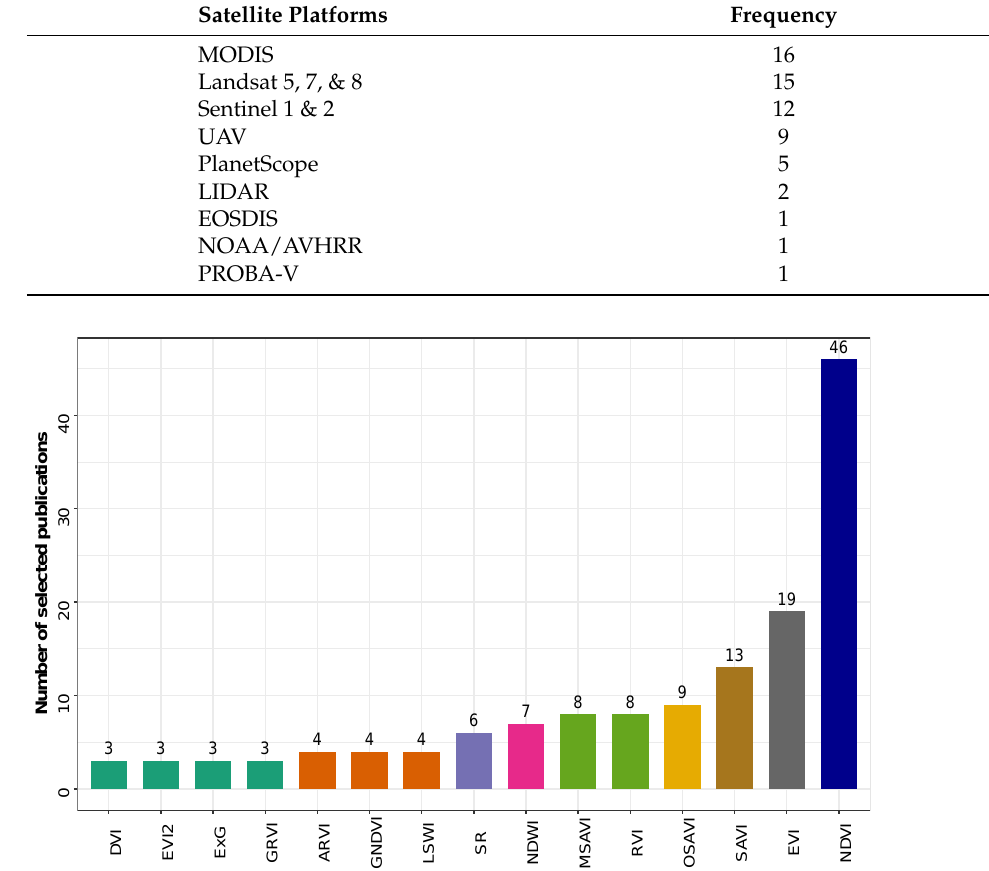
Figure 2. Vegetation indices versus the number of selected publications collected from database sources. Frequency of use of vegetation indices is sorted from lowest to highest. NDVI—normalized difference vegetation index, EVI—enhanced vegetation index, SAVI—soil-adjusted vegetation index, OSAVI—optimized soil-adjusted vegetation index, RVI—relative vigor index, MSAVI—modified soil-adjusted vegetation index, NDWI—normalized difference water index, SR—simple ratio, LSWI—land surface water index, GNDVI—green NDVI, ARVI—atmospherically resistant vege- tation index, GRVI—green and red ratio vegetation index, ExG—excess green, EVI2—2-band EVI, and DVI—difference vegetation